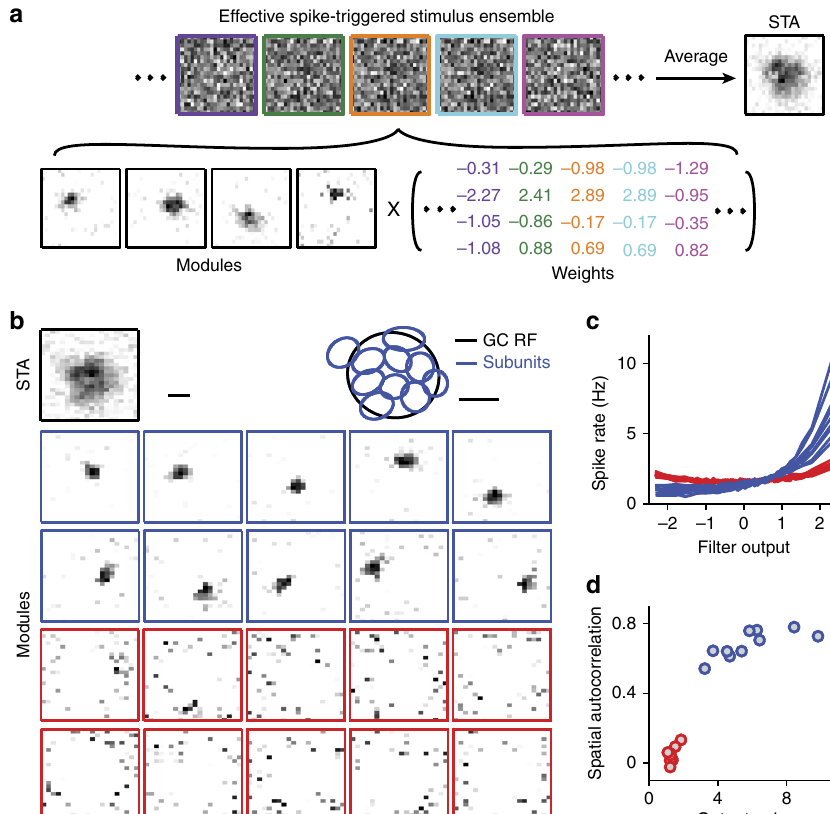
Fig. 1 Identi fi cation of subunits with STNMF. a Illustration of STNMF analysis. Samples of a ganglion cell ’ s effective spike-triggered stimulus ensemble ( top ), whose average corresponds to the cell ’ s spike-triggered average (STA). For easier visual comparison with the subunits, STAs are here and in subsequent plots displayed with negative pixel values set to zero and with zero corresponding to white in the greyscale image. STNMF decomposes this ensemble into a set of modules and a weight matrix ( bottom ). The example here shows four modules that were identi fi ed for a sample ganglion cell. b Modules obtained for another sample ganglion cell by applying STNMF with 20 modules. Some modules have a strongly localized structure ( blue frames ), others are more noise-like ( red frames ). The top row shows the cell ’ s receptive fi eld, given by the spatial component of the STA, as well as the fi tted receptive fi eld outline (GC RF, black ellipse ), together with outlines of the localized subunits ( blue ellipses ). Scale bars, 100 µ m. c Nonlinearities for the 20 modules, with colors corresponding to the frame colors in b . d Quanti fi cation of spatial autocorrelation, obtained as Moran ’ s I , vs. output gain, obtained as the spike-rate range of the nonlinearities shown in c , for the 20 modules. Colors as in b and